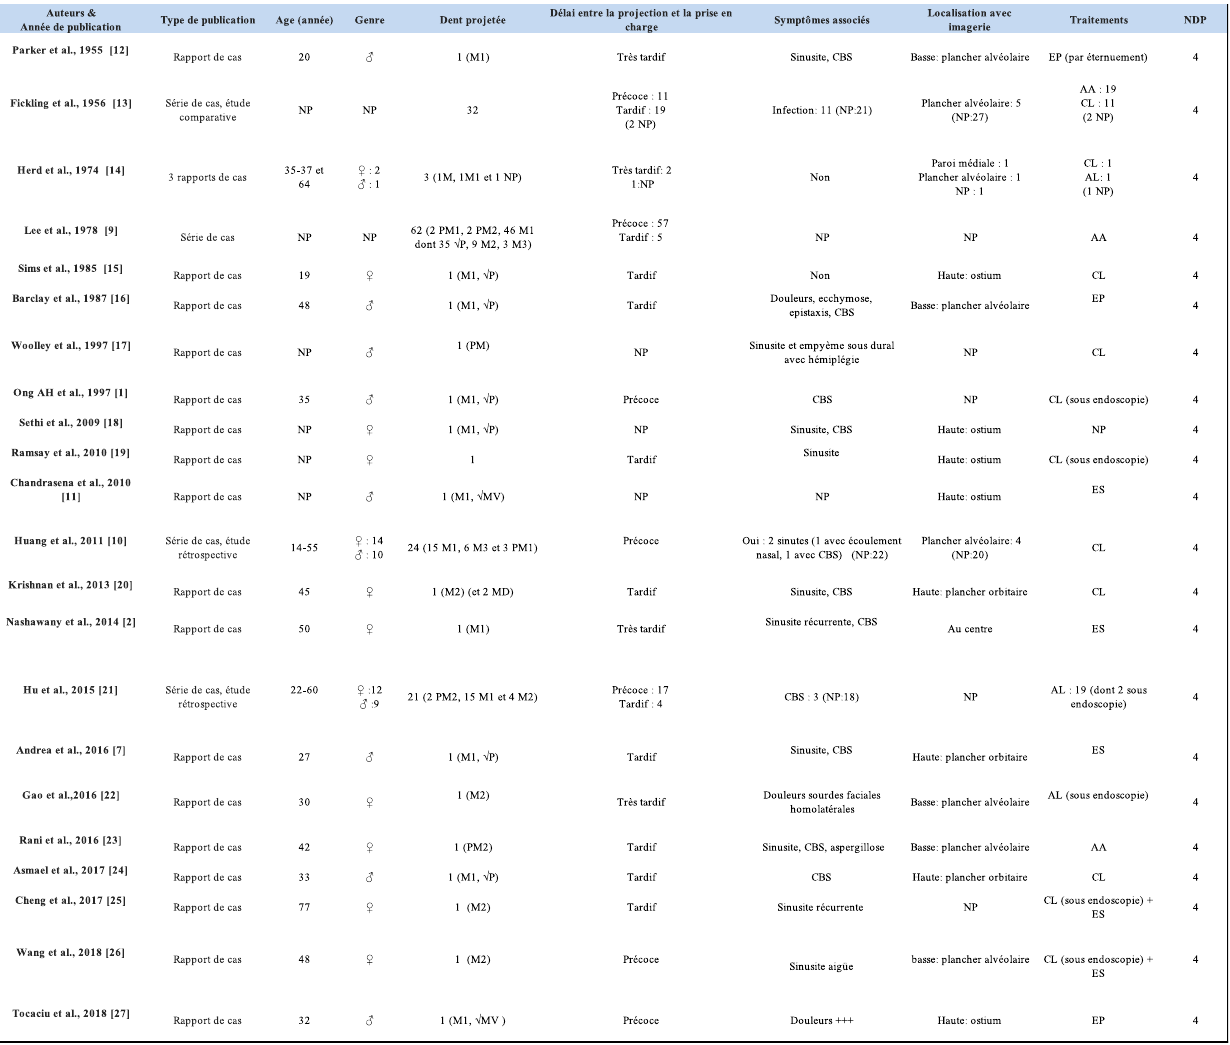
Table I. Main information of the selected articles. NP: not speci fi ed; M: molar; M1: fi rst molar; M2: second molar; M3: third